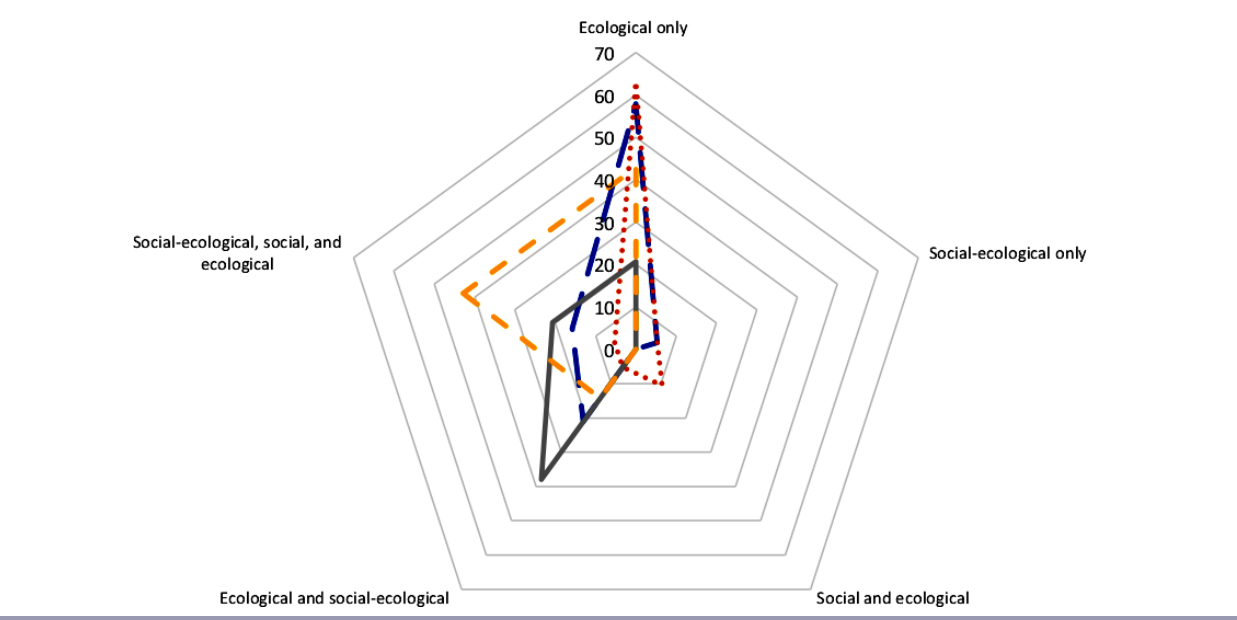
Fig. 5 . Percentage of monitoring initiatives at each level of Indigenous participation, displayed according to the type of indicators used. Initiatives are classified according to the degree of participation of Indigenous people: the blue dashed line indicates externally driven initiatives with Indigenous people as data collectors (IP1); the orange dotted line indicates collaborative initiatives with Indigenous people playing some role in design and execution (IP2); the grey solid line indicates collaborative initiatives with Indigenous people playing a strong role in design, execution, and management (IP3); and the yellow dashed line indicates autonomous monitoring by Indigenous people with some external support